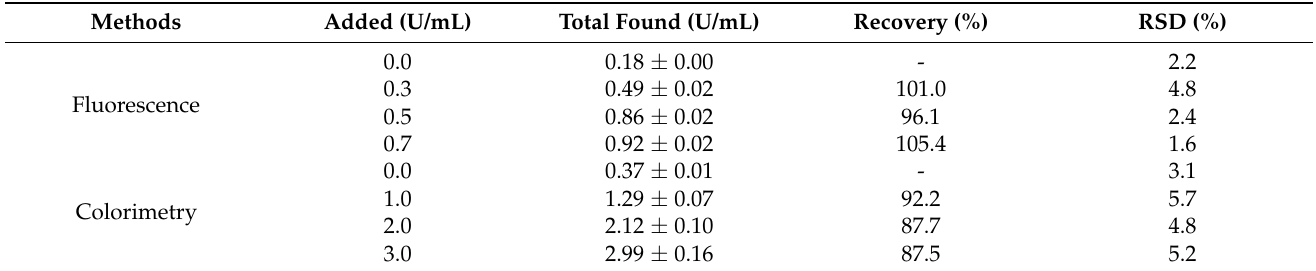
Table 3. Detection of β -glucosidase in crude almond sample ( n = 3